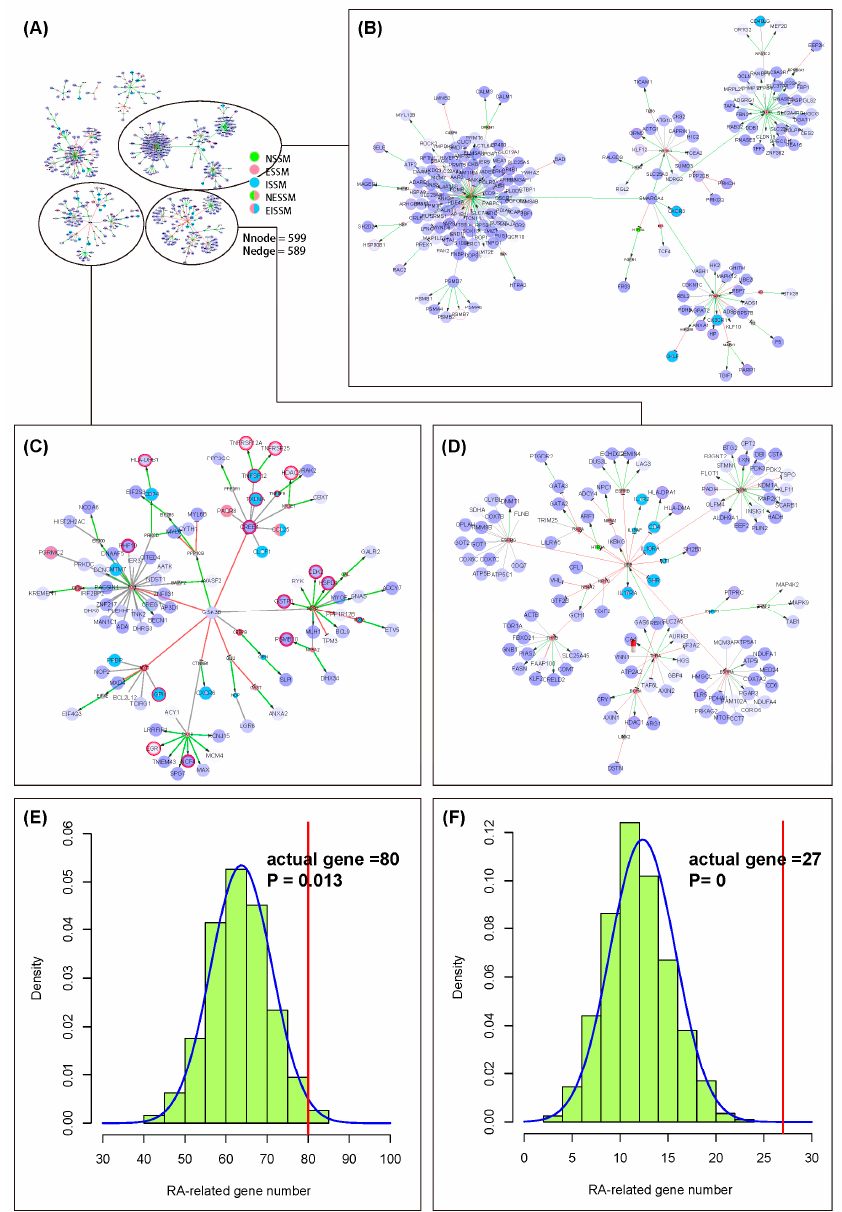
Figure 3. The application of the neuroendocrine immunomodulation (NIM) molecular network in the prediction of disease targets. ( A ) The overall graph of the rheumatoid arthritis (RA)-specific NIM subnetwork. The big nodes with purple color are the differentially expressed genes (DEGs); the deeper the color, the higher the fold change in the differential expression of the genes. The small nodes are the non-differentially expressed genes (non-DEGs). In addition, the nodes with a red circle are the RA-related genes. The meanings of the other network elements are the same as shown in Figure 1. ( B , C ) The partial enlargement network graph of ( A ); ( D ) The probability density curve of the number of RA-related genes obtained from the DEGs by permutation test; ( E ) The probability density curve of the number of RA-related genes obtained from non-DEGs by the permutation test. The RA-related genes are the biomarkers dataset of the RA download from the MetaCore database. The red vertical line is the actual number of RA-related genes in the RA-specific NIM subnetwork.